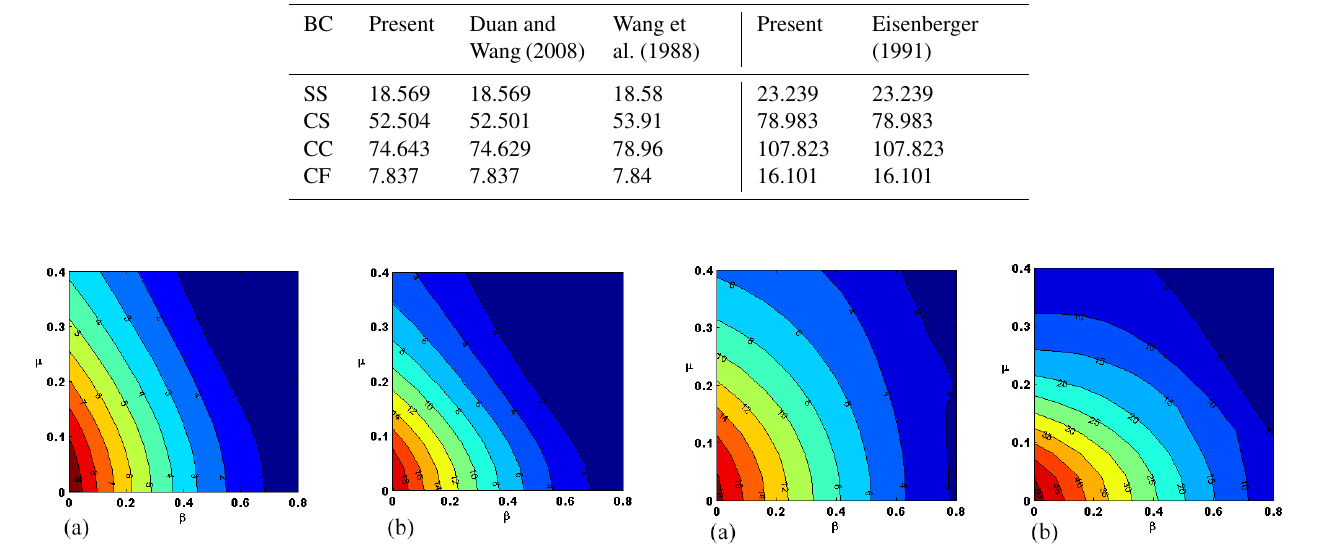
Figure 3. Contour plot of q 1 with respect to β and µ , (a) SS, (b)